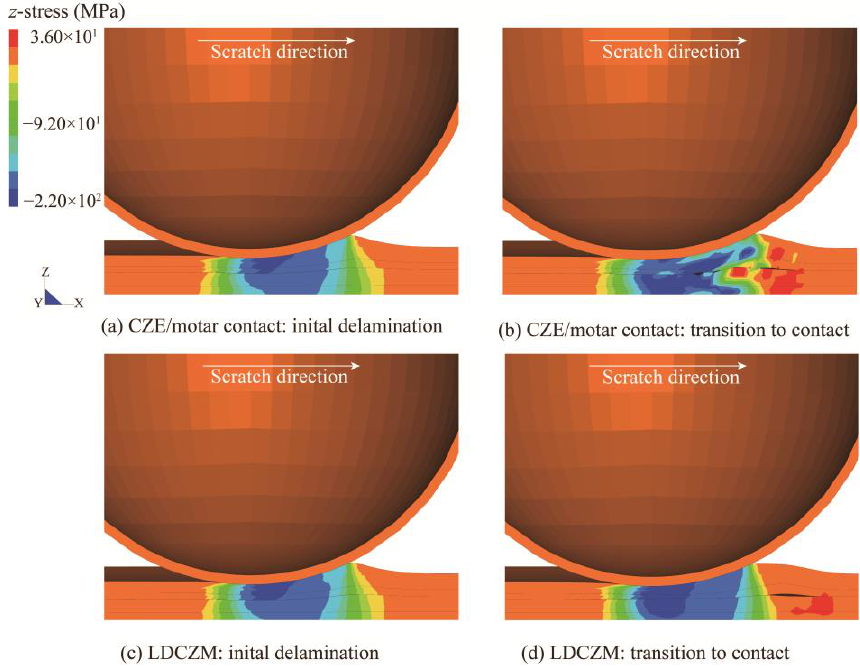
Figure 4. z -stress distribution predicted by ( a , b ) CZE/mortar contact and ( c , d ) LDCZM in scratch- induced delamination of the automotive coating system.